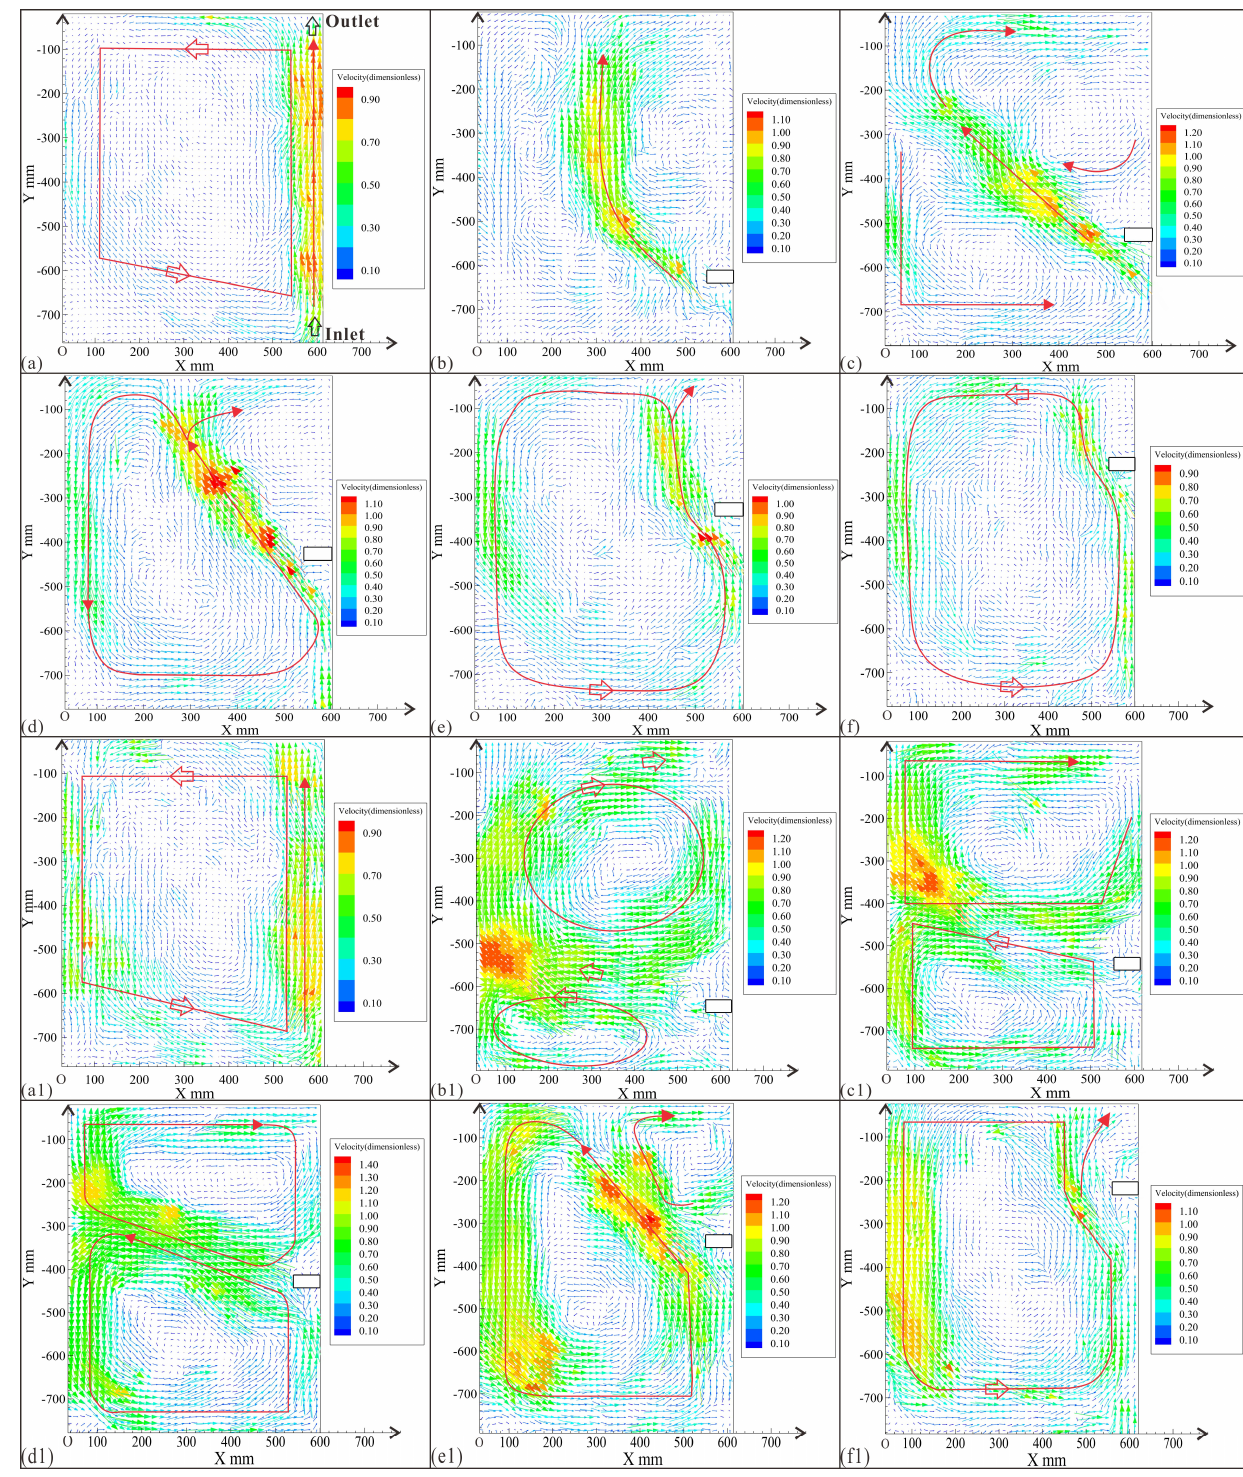
Figure 4. Vector distribution of the flow field under the influence of the rectangular column for Q = 3.7 L/min and 6.8 L/min, respectively: ( a – f ) for 3.7 L/min; ( a1 – f1 ) for 6.8 L/min. Vector distribution ( a , a1 ) for no structure; ( b , b1 ) for l = 0.19; ( c , c1 ) for l = 0.31; ( d , d1 ) for l = 0.44; ( e , e1 ) for l = 0.56; ( f , f1 ) for l = 0.69.